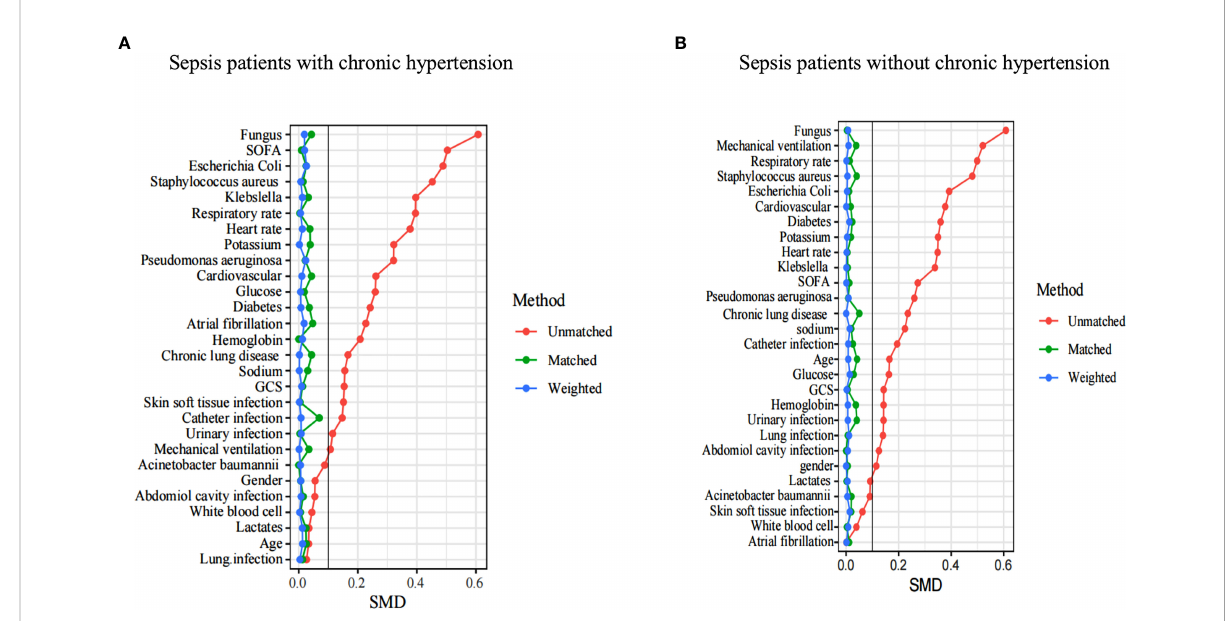
FIGURE 4 A SMD of the original cohort was compared with the SMD of the IPTW cohorts. In sepsis AKI incidence, sepsis patients with hypertension (A) and sepsis patients without hypertension (B) showed that covariates were well balanced between classes after IPTW(<0.1). SMD, standardized mean difference, IPTW, inverse probability of treatment weighting